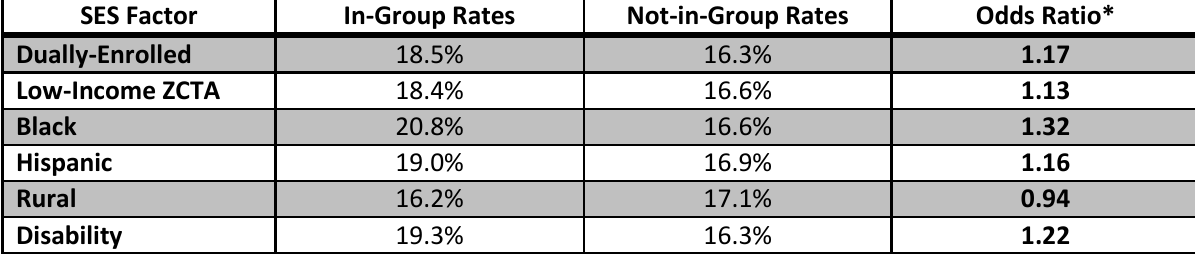
Table 12.3: Beneficiary Level Social Risk Factors and Readmission Rates, Fiscal Year 2014